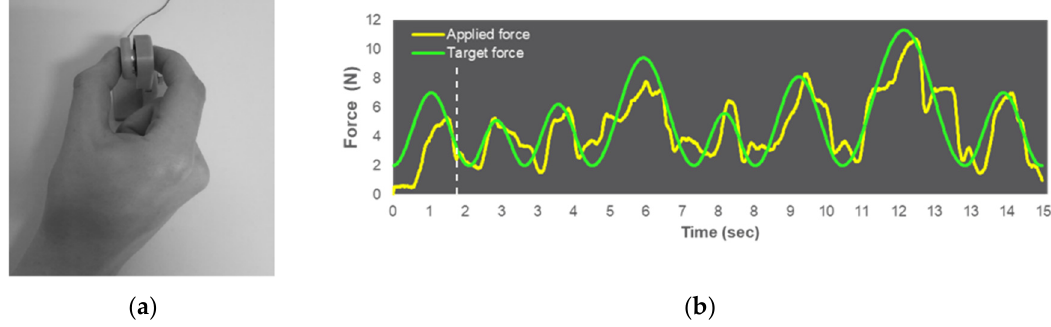
Figure 1. ( a ) Participant performs a precision grip on the force transducer (FT). ( b ) Example illustration of the required sine wave pattern of the FM task with the target force (green line) and applied force (yellow line). The dashed line represents the starting point of the data analysis (1.75 s after the trial’s onset), and was not visible during the experiment.